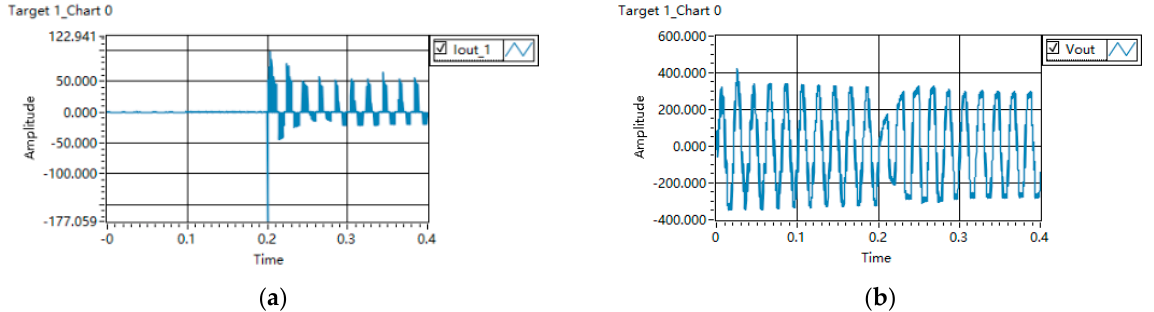
Figure 14. Experimental results of UPS with current-limiting method ( a ) output current of phase A, ( b ) output voltage of phase A.